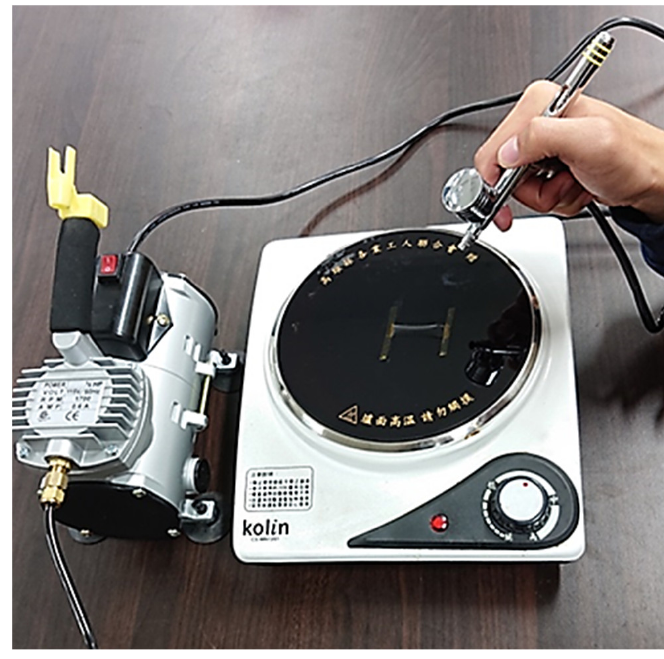
Figure 1. Experimental setup of gun spray deposition.